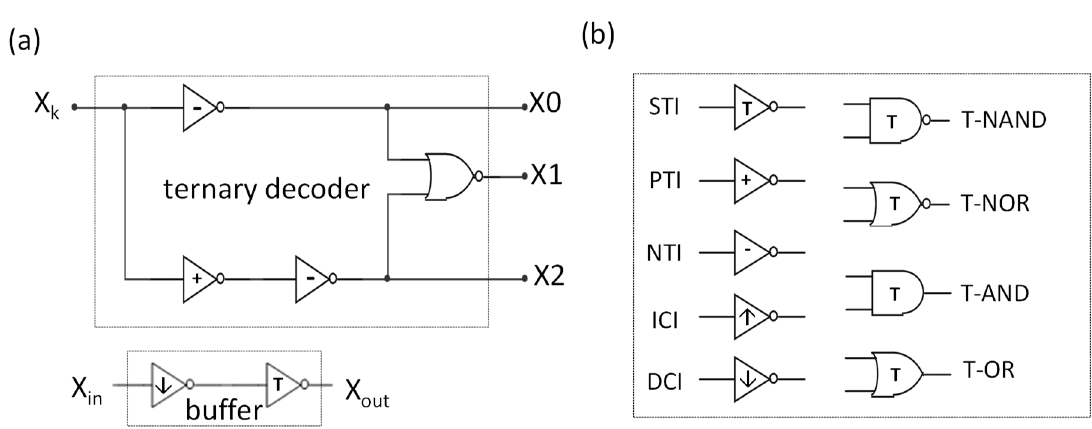
Figure 4. ( a ) Design of the ternary decoder and ternary buffer. ( b ) Symbols of all the ternary logic gates discussed in this work. Note: The unlabeled logic gates represent the normal binary logic gates.